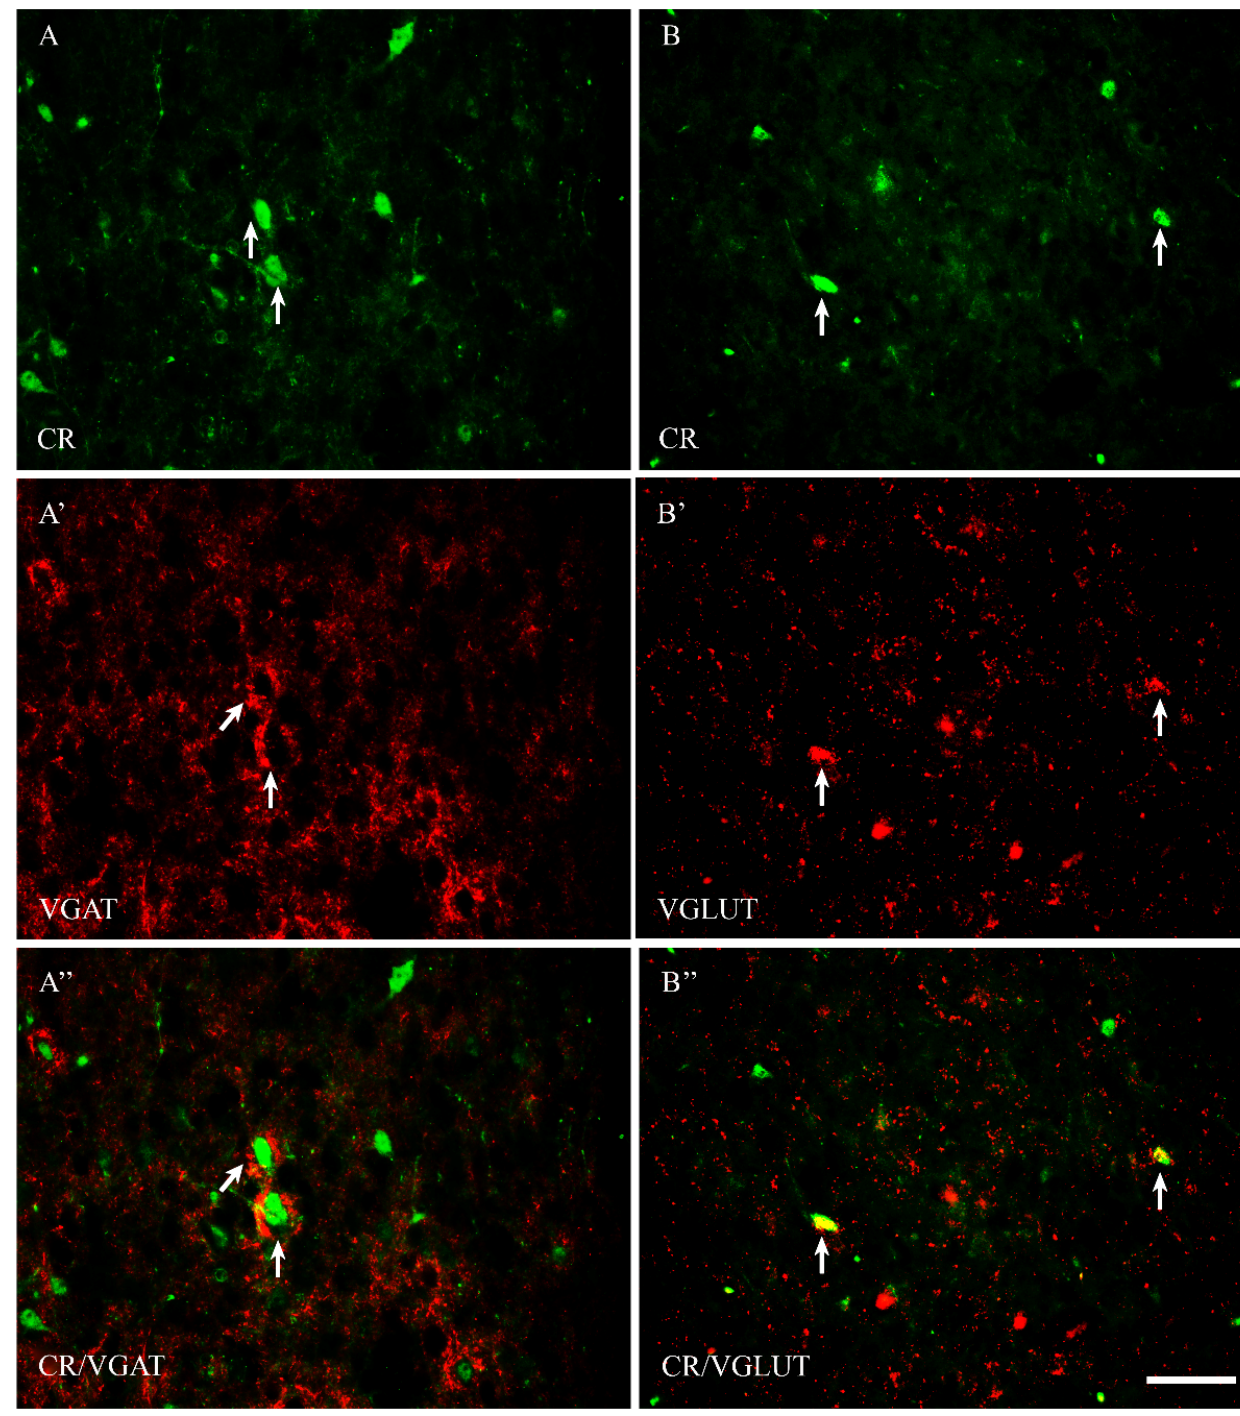
Figure 3. Representative microphotographs demonstrating the anatomical relationships between CR+ neurons and VGAT ( A–A” ) as well as CR+ neurons and VGLUT ( B–B” ) in the periventricular preoptic nucleus of the guinea pig. Arrows indicate double-labelled cells. Scale bar = 50 μ m .